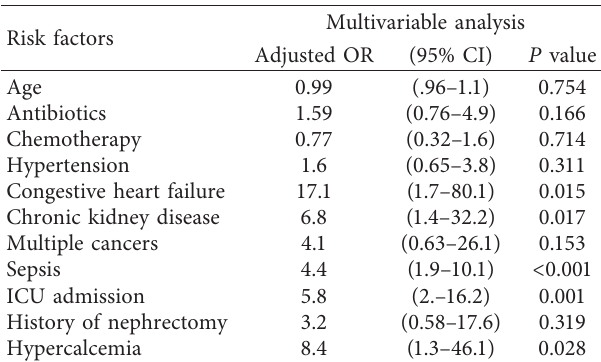
Table 4: Logistic regression analysis for factors associated with AKI in patients